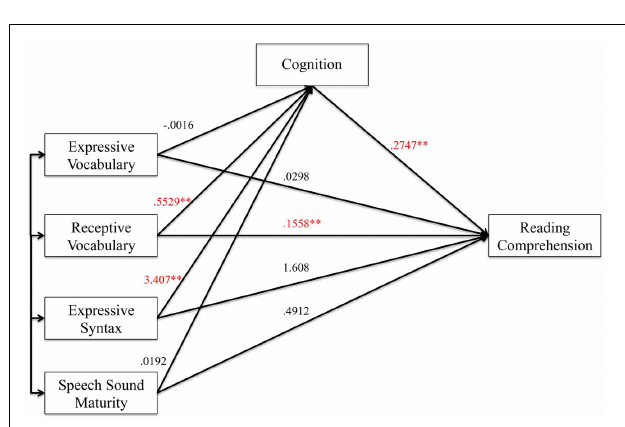
FIGURE 7 | Direct effect model (with mediator) for oral reading fluency. Figure 7 shows the direct effect model for preschool language and speech measures on oral reading fluency with cognition as the mediator. Unstandardized coefficients of correlations are included in model. Coefficients marked with a single asterisk are significant at the p < 0 . 05 level. Coefficients marked with a double asterisk are significant at the p < 0 . 01